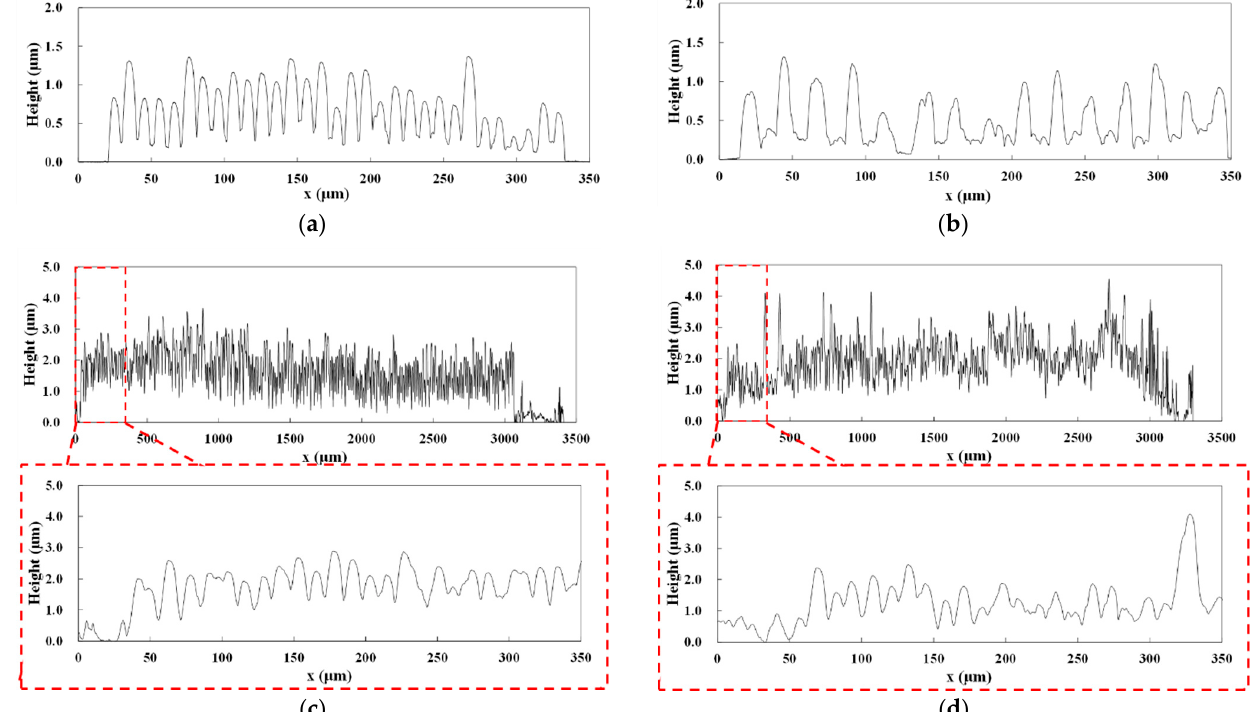
Figure 6. Cross-sections of the patterns. ( a ) Patterns on glass substrates at a scanning speed of 5 mm/s and pulse energy of 0.49 nJ. ( b ) Patterns on glass substrates at a scanning speed of 0.5 mm/s and pulse energy of 0.74 nJ. ( c ) Patterns on PDMS substrates at a scanning speed of 10 mm/s and pulse energy of 0.49 nJ. ( d ) Patterns on PDMS substrates at a scanning speed of 1 mm/s and pulse energy of 0.37 nJ. Table 1. Resistivity of the patterns fabricated on glass and PDMS substrates under various laser irradiation conditions.